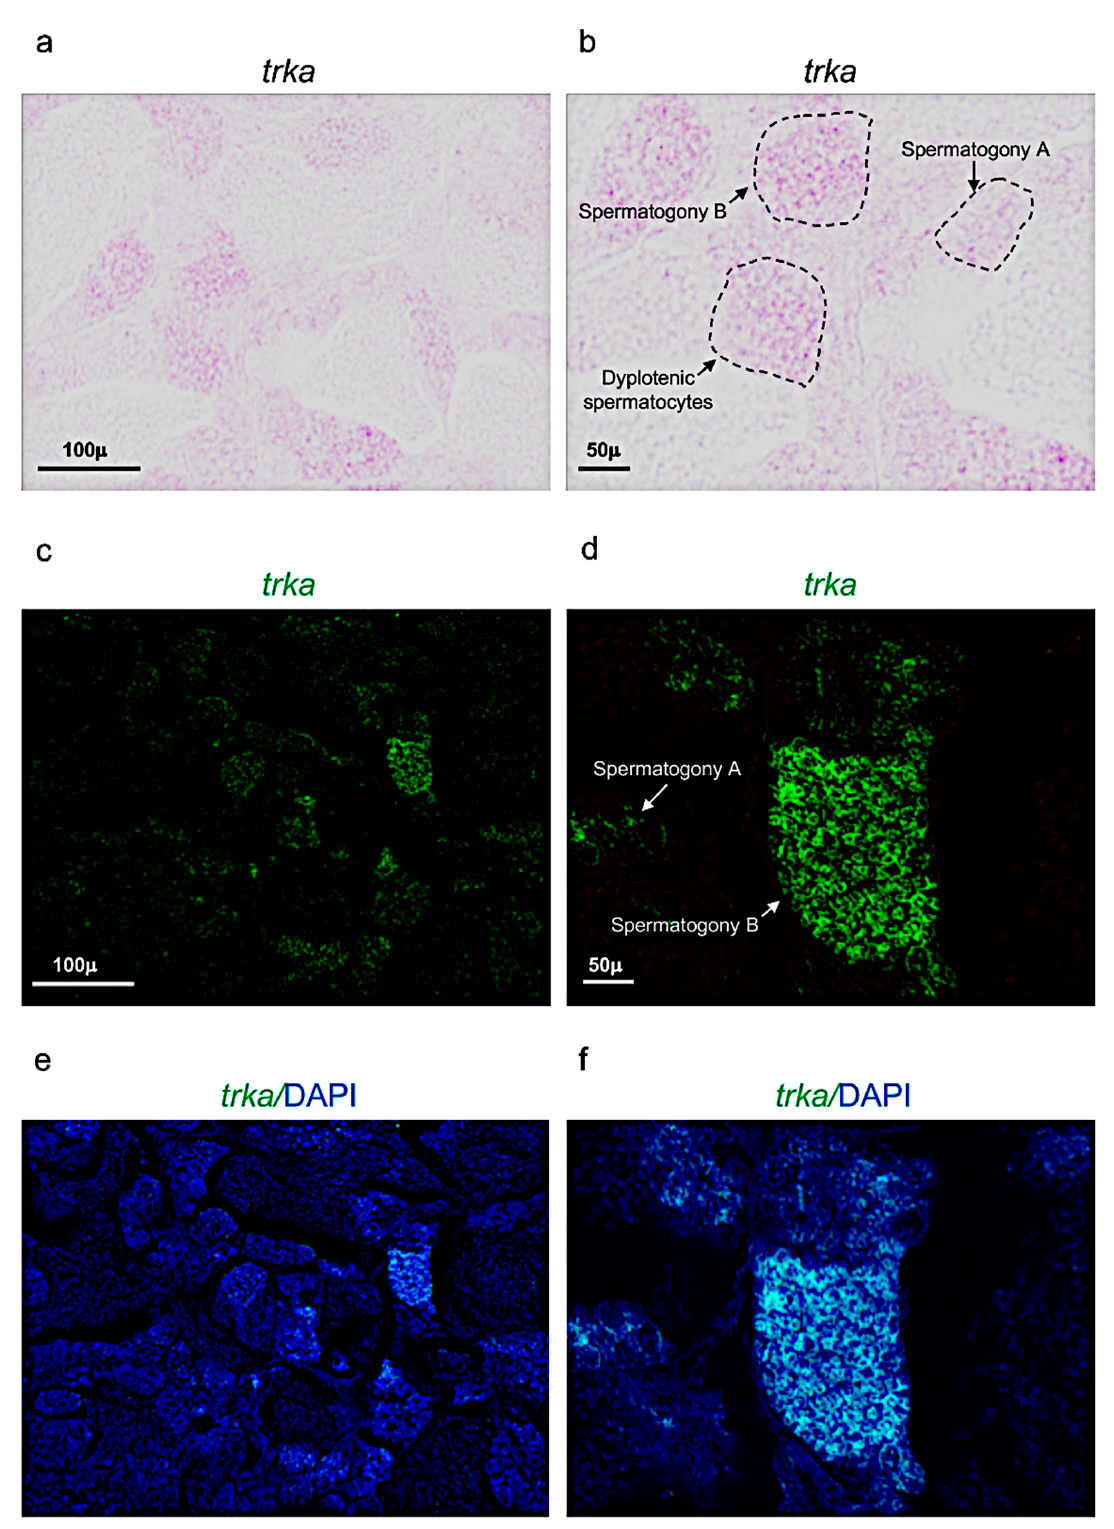
Figure 4. Trka expression pattern in adult zebrafish testis. ( a , b ) Chromogenic in situ hybridization of trka in adult zebrafish testis. ( c , d ) Fluorescence in situ hybridization of trka in adult zebrafish testis. ( e , f ) Fluorescence in situ hybridization of trka and cell nuclei (DAPI) in adult zebrafish testis. Scale bars: 100 µ ( a , c , e ); 50 µ ( b , d , f ).